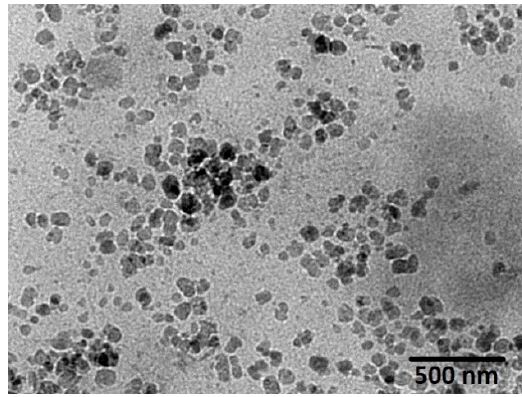
Figure 6. TEM photomicrograph of the optimized ICA-Cubs.